Question: Is the quantity shown trending increasing or decreasing?
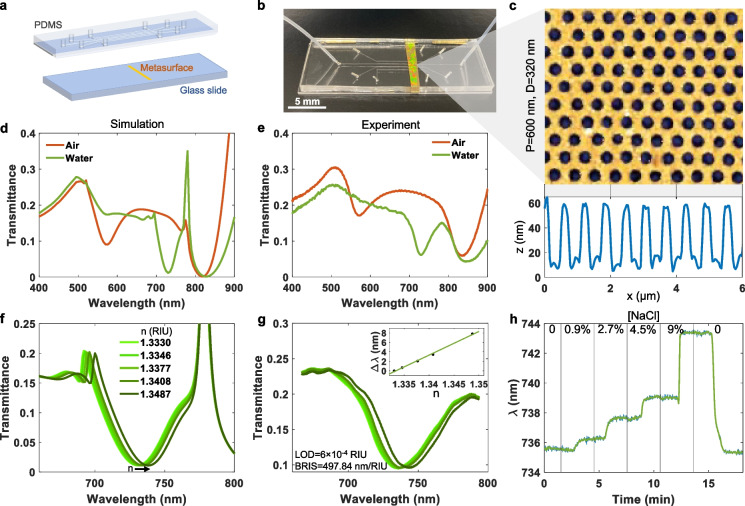
Answer: increasing